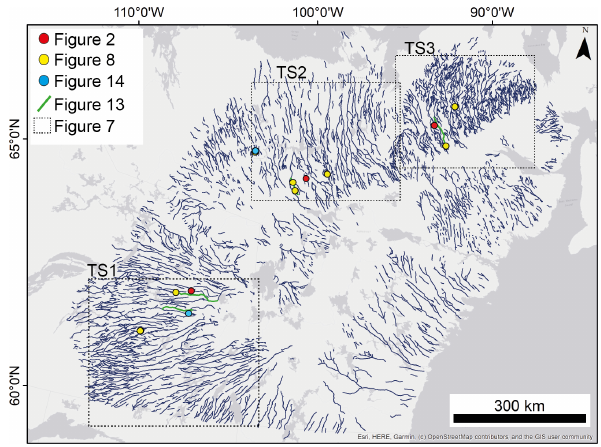
Figure 5. Integrated map of meltwater routes. Note how meltwater routes in this new map are less fragmented and denser than the ex- isting esker map (Fig. 2b). Points and boxes represent locations of other